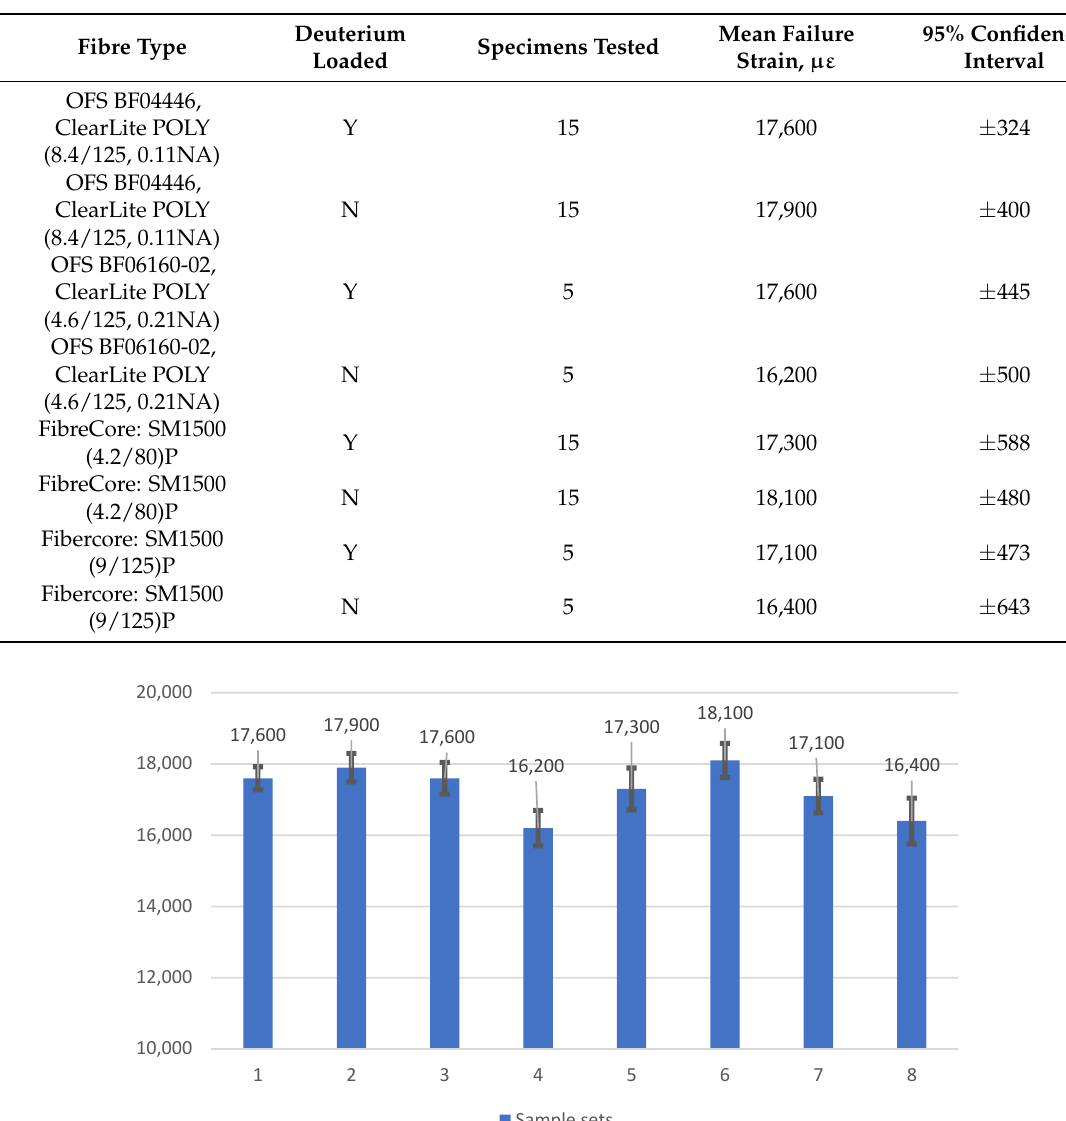
Table 4. Fatigue test results for the Type II trans-jacket gratings.